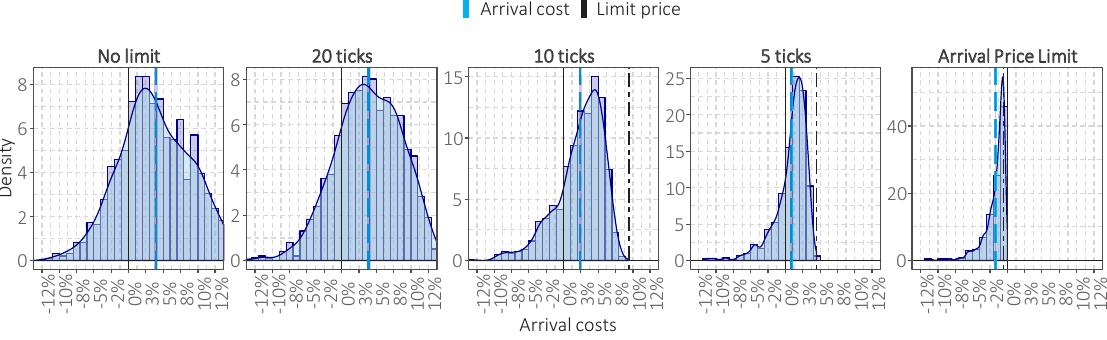
Figure 6. Arrival cost distribution for various limit